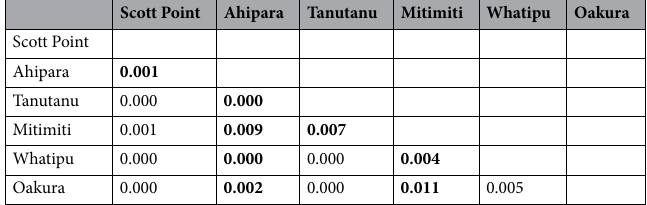
Population genetic structure. The PCoA plot of multilocus microsatellite variation (site-specific means ± SE) revealed clear separation amongst most samples (Fig. 1). There was no pronounced separation of samples based on geography, although the two northern-most sites (Scott Point, Ahipara) were both located to the left of the plot (negative PCoA 1 values). Three sites (Tanutanu, Mitimiti, Oakura—listed north to south) were located close to one another with some degree of overlap on both the x and y axes. The Whatipu sample (mid-point of our sampling range) was differentiated from all other samples.